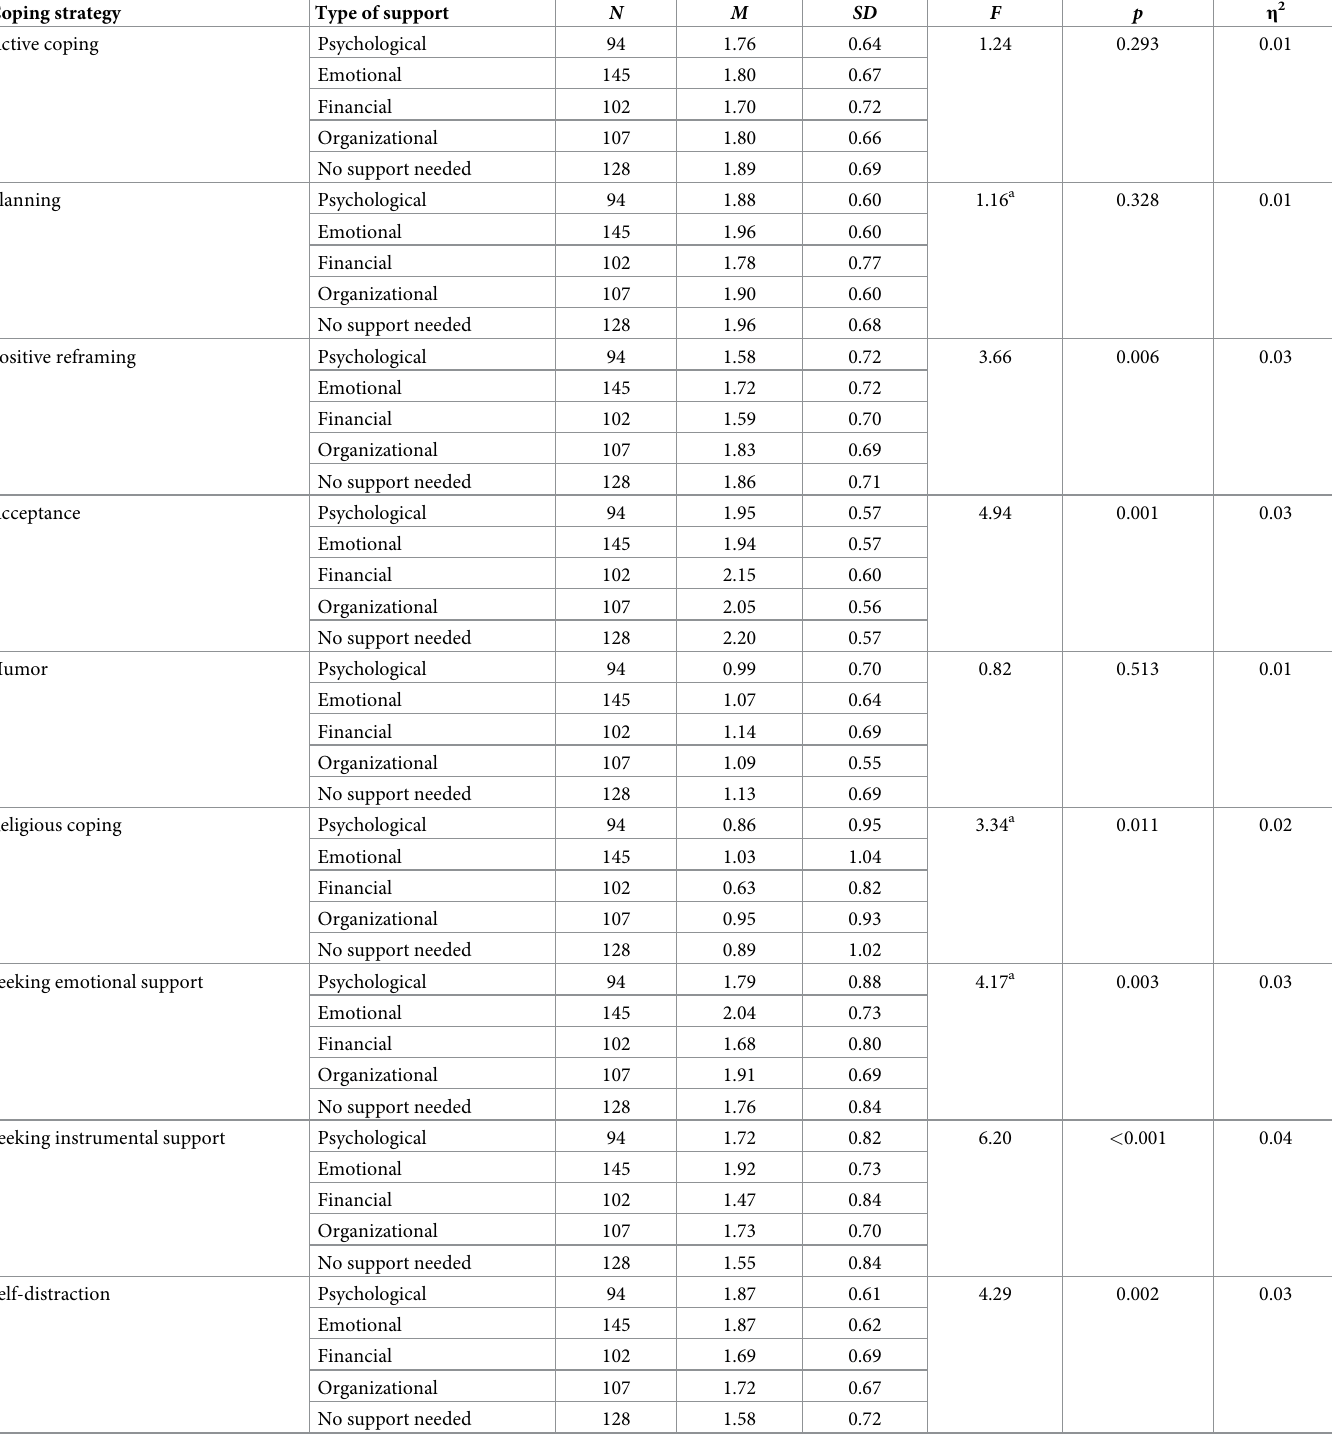
Table 10. One-factor analysis of variance of differences in coping strategy use depending on the type of support needed. Coping